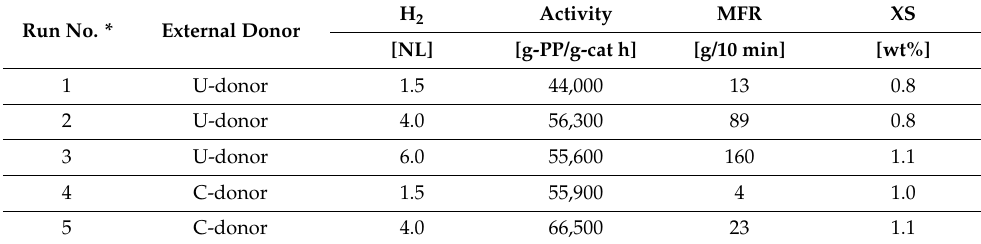
Table 1. Propylene polymerization results by U- and C-donors under various hydrogen concentrations.